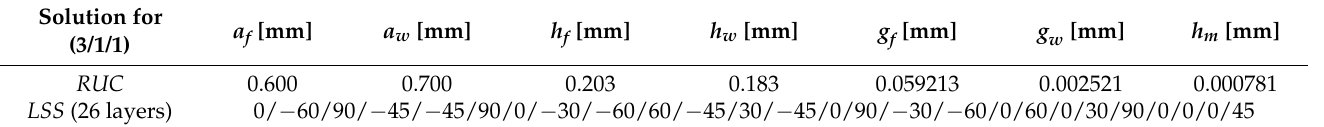
Table 5. The best solution found when using 3/1/1 fabric as reinforcement.